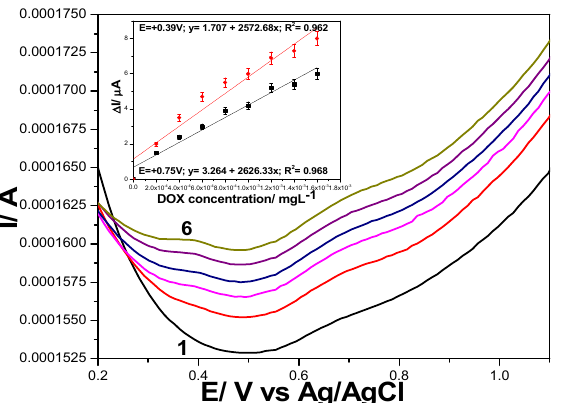
Figure 9. Differential pulse voltammograms recorded at GRQD/CNT paste electrode in 0.1 M Na 2 SO 4 supporting electrolyte (curve 1) and in the presence of various DOX concentrations: 0.0002–0.0018 mg · L − 1 (curves 2 to 10) under operating conditions: MA of 0.200 V and SP of 0.010 V; Inset: Calibration plots of current recorded at: (a) +0.390 V vs. Ag/AgCl and (b) + 0.750V vs. Ag/AgCl, vs. DOX concentrations.